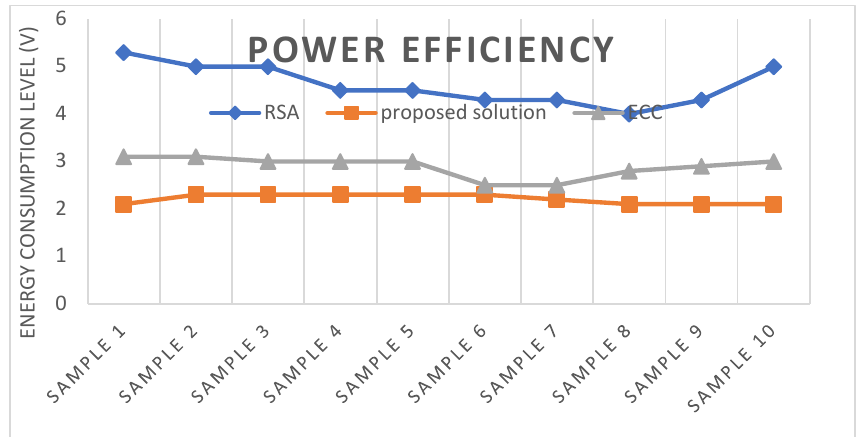
Figure 10. Power efficiency.